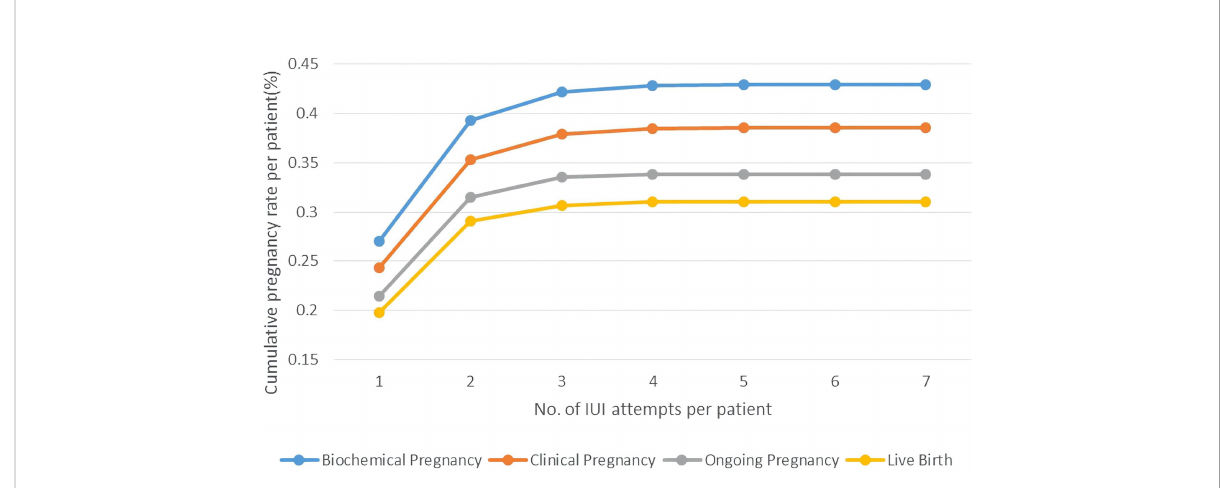
TABLE 5 The basal characteristics of PCOS patients undergoing IVF and three attempts of IUI after PSM, and the pregnancy outcomes of these two groups of patients. Variables